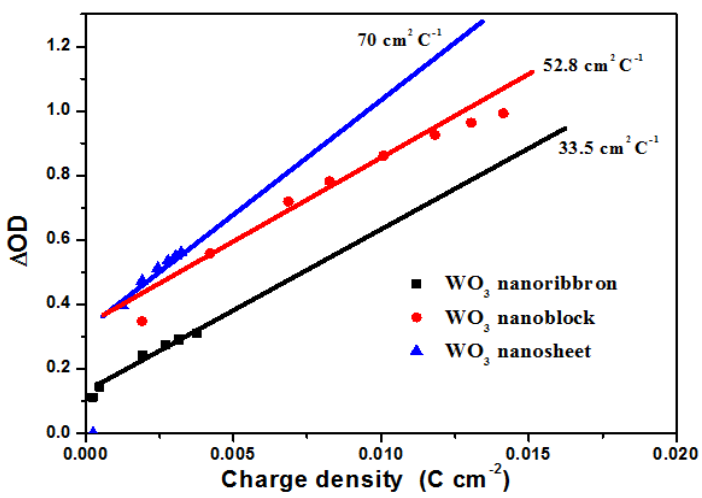
Figure 5. Coloration efficiency curves of the WO 3 nanoblock, nanosheet, and nanoribbon array films. Cycling stability is an important parameter for practical electrochromic applications.